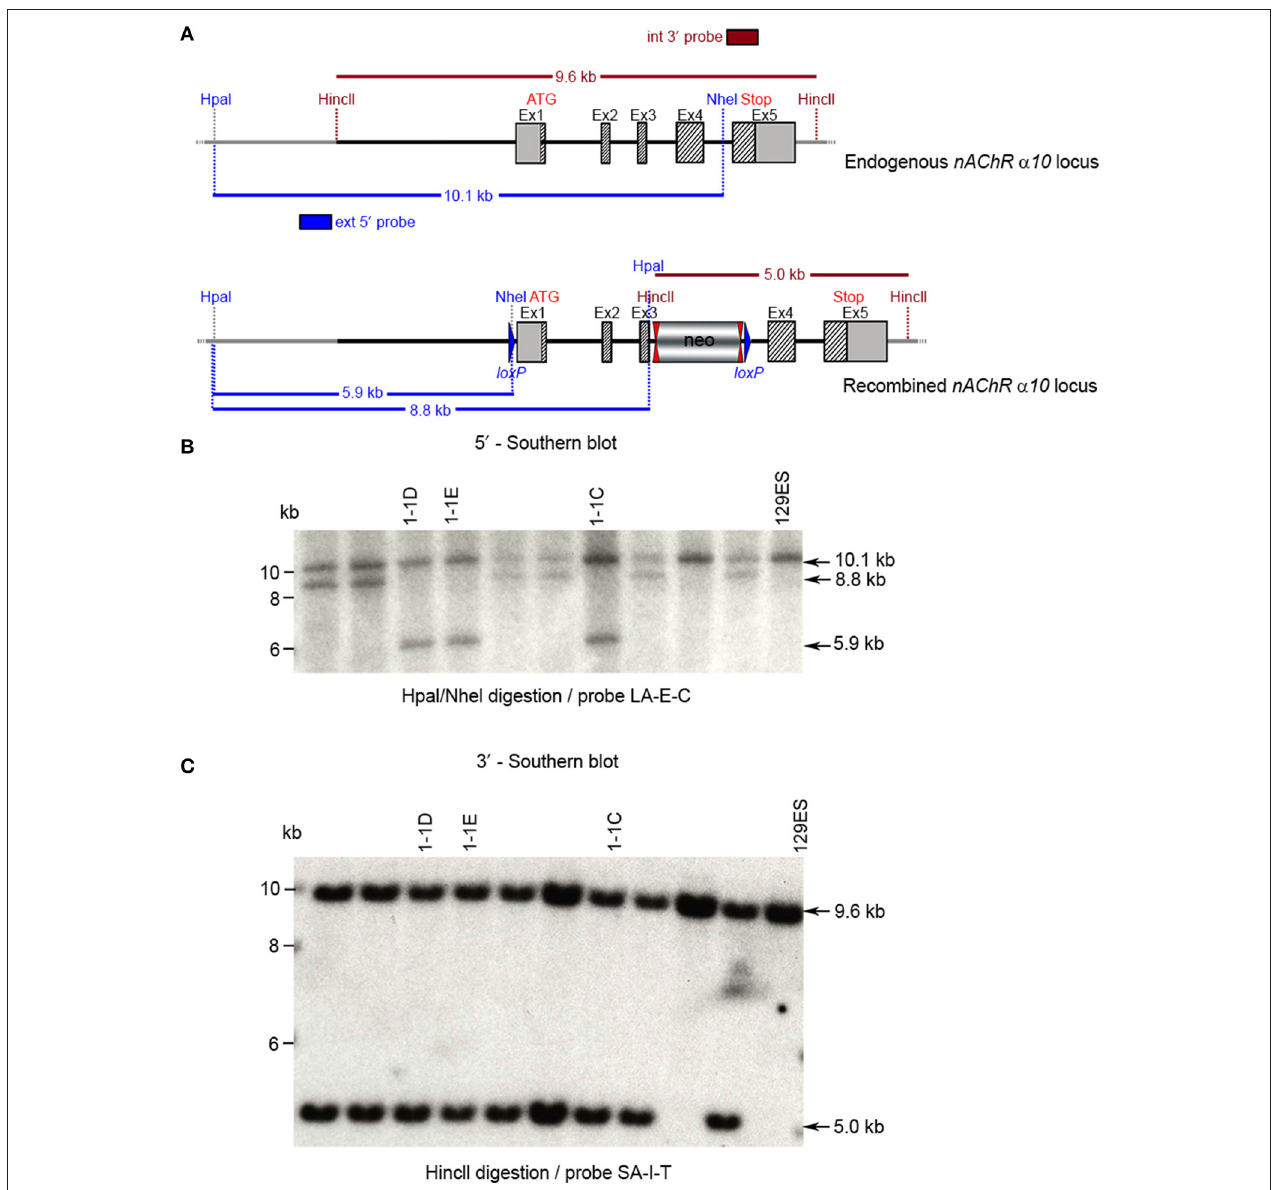
FIGURE 6 | Southern blot analysis for 5 ′ and 3 ′ homologous recombination in ES cells ( α 10 nAChR). The genomic DNA of the 10 tested ES cell clones was compared with wild type DNA from 129ES. (A) Schematic representation of the WT and recombined α nAChR alleles with the relevant restriction sites for the Southern blot analysis. (B) DNA was digested with Hpal/Nhel and blotted on nylon membrane and hybridized the external 407 bp 5 ′ probe (LA-E-C) or (C) DNA was digested with HincII and hybridized to the internal 602 bp 3 ′ probe (SA-I-T) to screen for the 5 ′ and 3 ′ homologous recombination. The external 407 bp 5 ′ probe was generated by PCR on genomic DNA using the primer pair CTCTGTTTTCCTGTAGGTGG/GAAGGTAGGACTGGGTAAGG. The 5 ′ probe (LA-E-C) hybridized downstream of the 5 ′ homology sequence of the targeting vector, which also allowed detection of the ES cell clones in which the targeting vector was integrated in a non-homologous manner. The 602 bp internal 3 ′ probe (SA-I-T) was generated by PCR on genomic DNA using the primer pair GCCCTTACTTTATCCTTCCCCACA TCG/CAGCTCCCTGAAATCCAGTTCCTGG. The expected size of the WT allele was10132 bp and the recombined allele 5,922 bp, respectively, with the 5 ′ probe and 9,567 and 5,024 bp, respectively, with the 3 ′ probe. Cell clones 1-1D, 1-1E, and 1-3C all showed WT and recombined signals of similar intensity and were chosen for blastocyst injection.